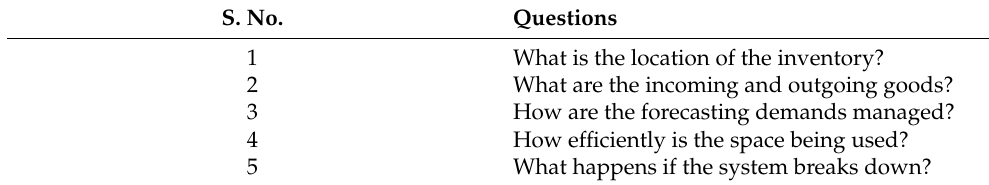
Table 1. Data collection during the case